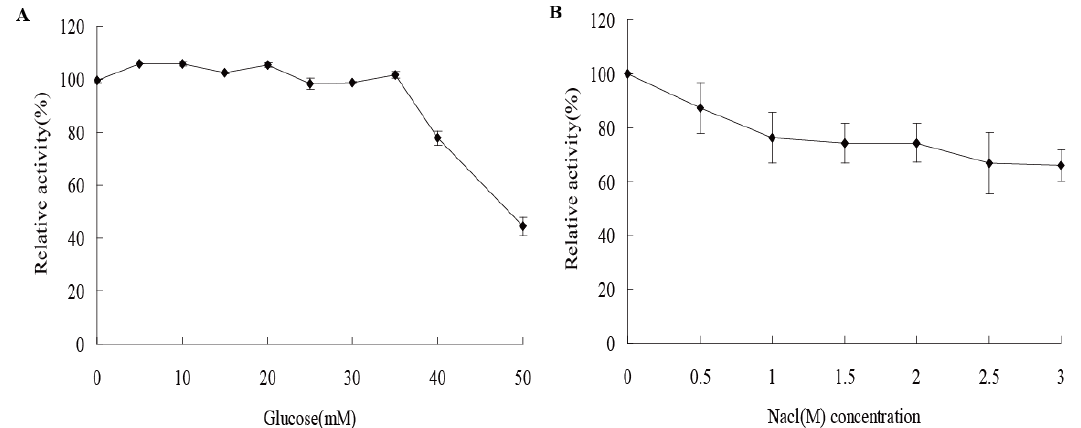
Figure 4. Effect of different ( A ) glucose and ( B ) NaCl concentrations on AfCel5A activity.